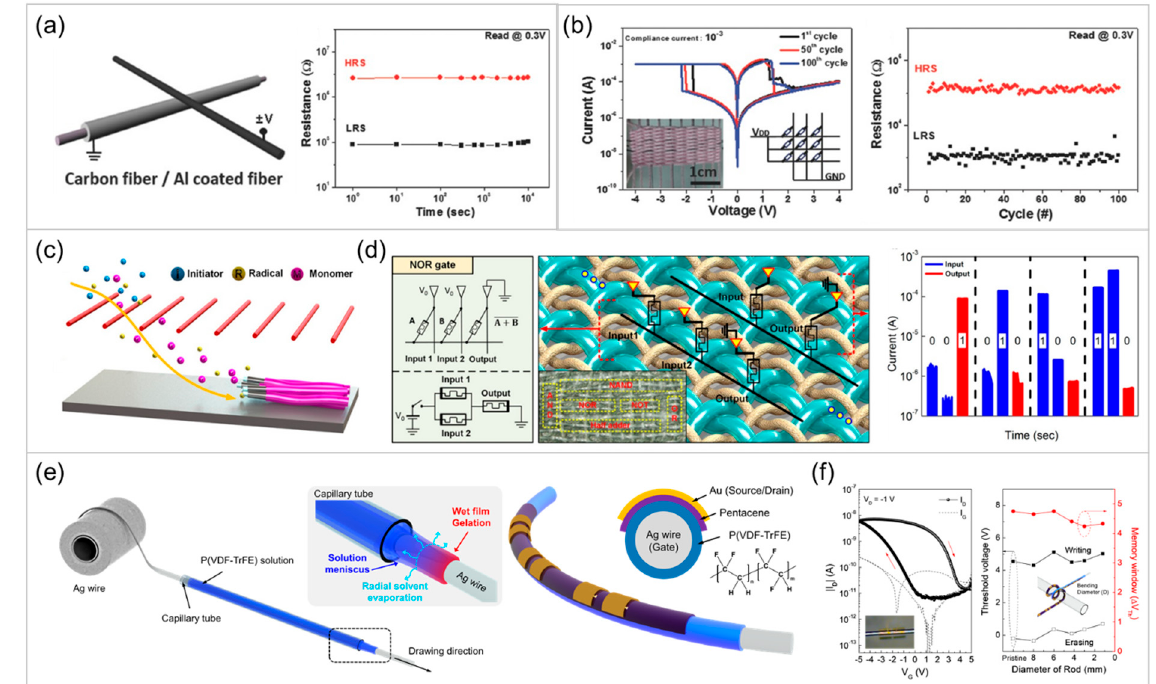
Figure 3. ( a ) Schematic of the device structure and the retention property of a fiber-shaped memory device ( b ) Endurance test of a 3 × 3 RRAM array embroidered into a fabric. ( a , b ) Reproduced with permission Ref. [34]. Copyright 2017, Wiley-VCH. ( c ) Schematic illustration of the deposition of pEGDMA using an iCVD process. ( d ) Left: schematic of the logic-in-memory operations of NOR gate and its equivalent circuits within the crossbar array. The inset presents a conceptual image for the integration of logic gates on the fabric. Right: measurements of the NOR gate. ( c , d ) Reproduced with permission Ref. [35]. Copyright 2017, American Chemical Society. ( e ) Schematic illustration of a continuous reel-to-reel coating process and the device structure of the FOMs. ( f ) Memory and bending characteristics of the FOMs. ( e , f ) Reproduced with permission Ref. [3]. Copyright 2019, American Chemical Society.